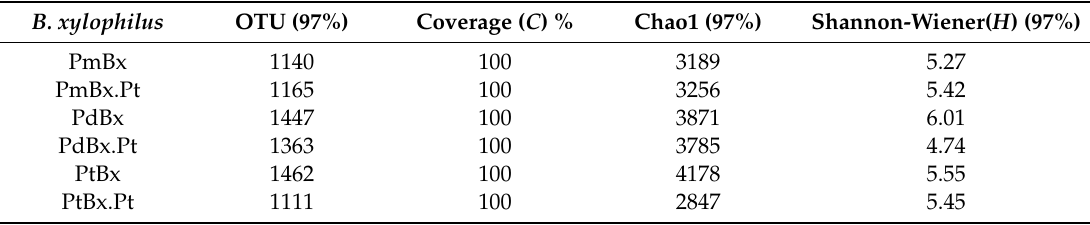
Table 2. Diversity index of bacteria associated with different Bursaphelenchus xylophilus isolates. 140 B. B.